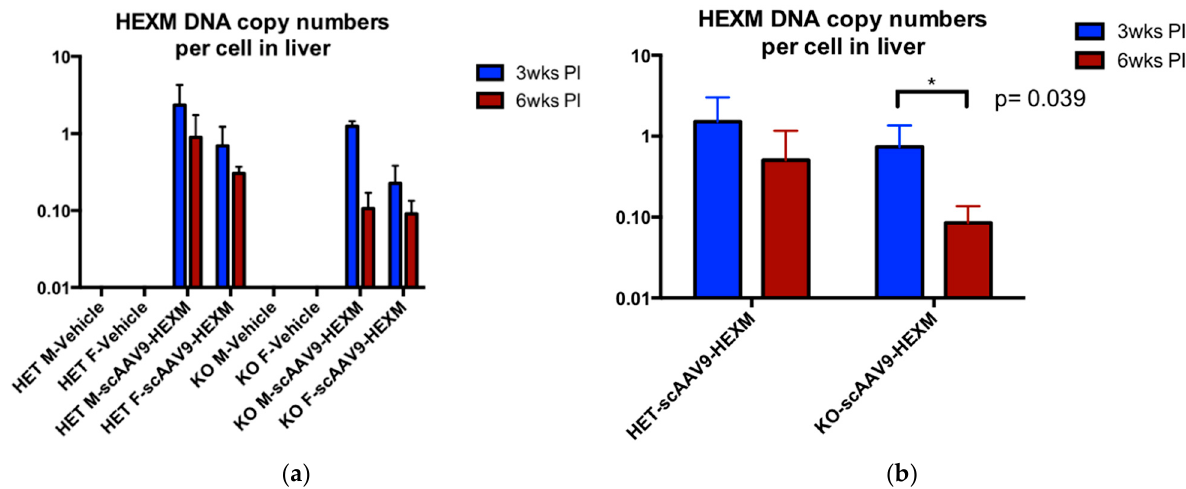
Figure 7. Vector biodistribution of scAAV9 ‐ HEXM in the liver of TSD mice. Biodistribution of the scAAV9 ‐ HEXM viral vector, in the liver, 3 weeks and 6 weeks post scAAV9 ‐ HEXM injection in TSD mice. ( a ) Comparison of scAAV9 ‐ HEXM treated to vehicle injected mice. ( b ) comparison of Het and KO mice. A lower biodistribution was evident in liver samples from mice terminated at the later time point compared to the earlier time point, significantly so in the KO mice (* = p < 0.05). M = male, F = female, wks = weeks, PI = post injection.